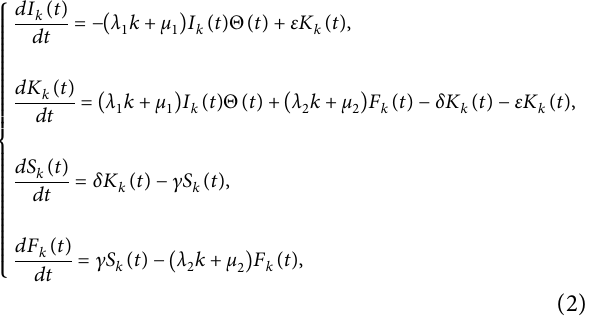
nonnegative and λ